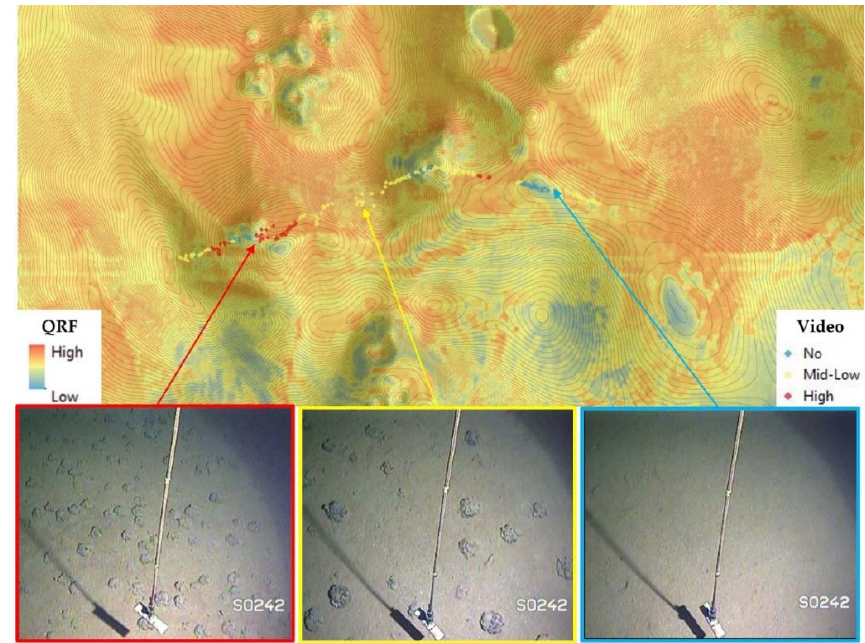
Figure 10. Semi-quantitative validation between the RF predictions and video observations (SO242- 1#135_OFOS-6). Prediction and observation have the same spatial trend, showing alternations between areas with higher, lower, and no PMN. The superimposed bathymetric contours have a 1 m